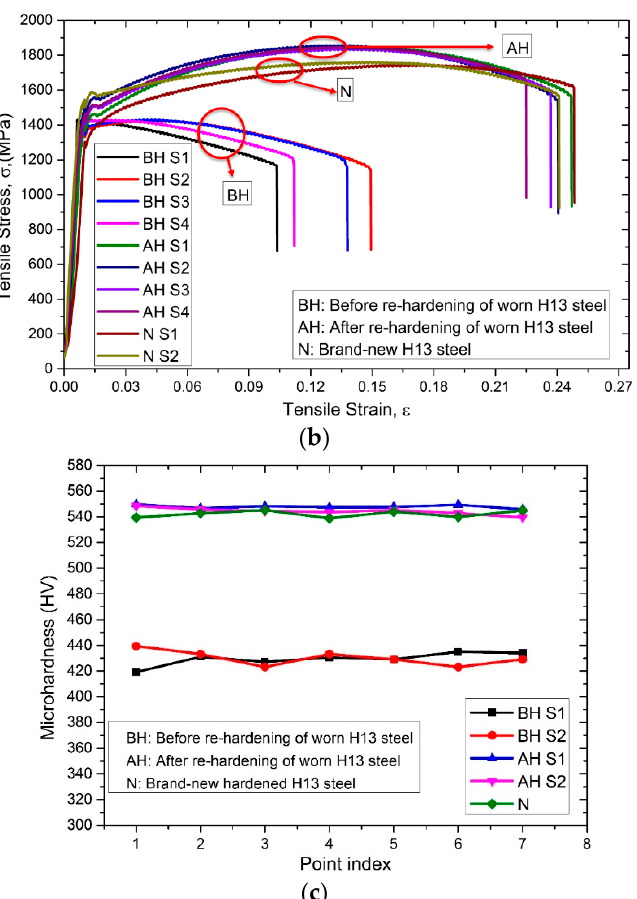
Figure 13. ( a ) Schematic diagram of the re-hardening process for H13 tool steel; ( b ) tensile testing data; ( c ) hardness measurements.